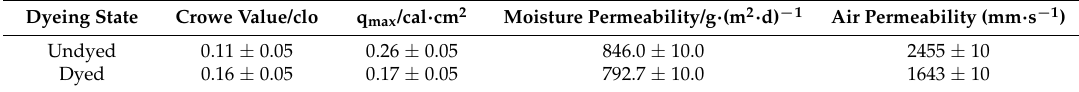
Table 7. Application properties of warp-knitted fabrics.